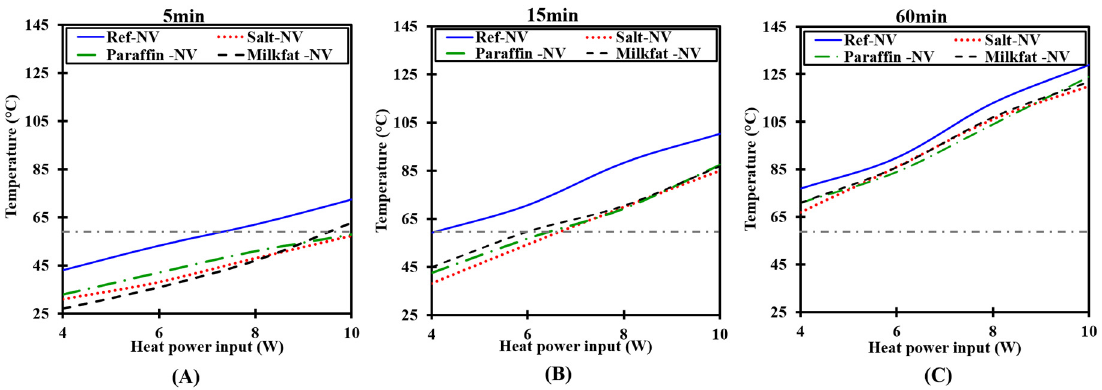
Figure 5. Average heat sink base surface temperature ( T b ) for three PCMs at 4–10 W heat loads under